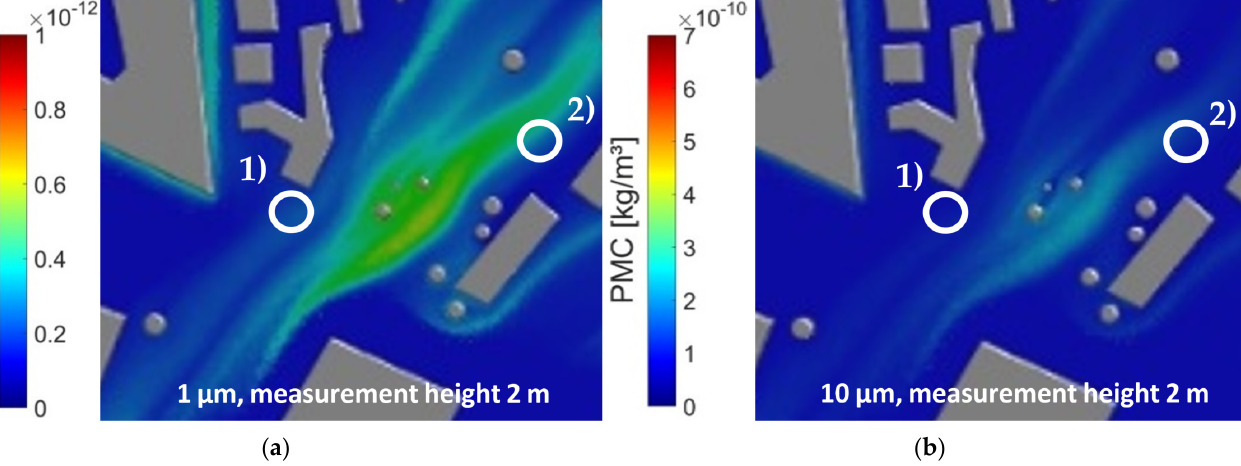
Figure 13. Simulated PMC of (1) main traffic intersection and (2) railway station for: ( a ) 1 µm particles; ( b ) 10 µm particles.